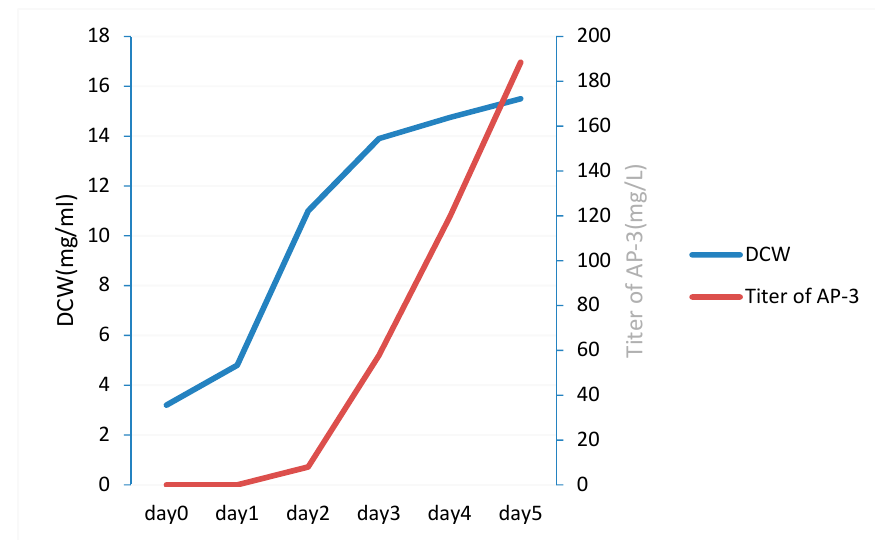
Figure 4. The dry cell weight (DCW) and titer of AP-3 in NXJ-24 mutant during fermentation process.